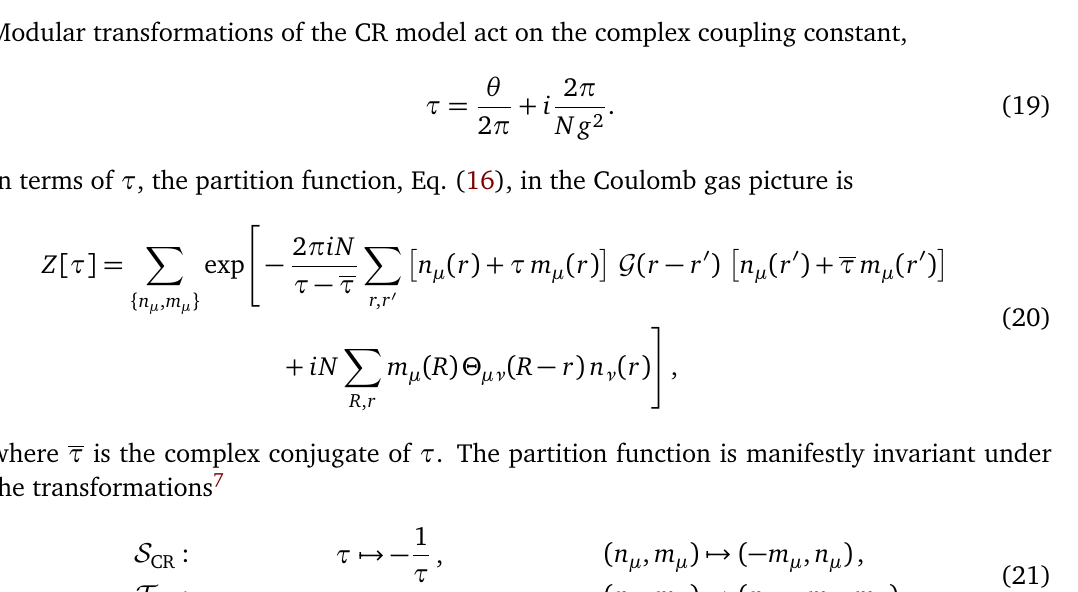
Figure 4: The phase diagram for the Cardy-Rabinovici model with N / C < 24 ] . Pink curves denote phase boundaries. The phases are labeled by ( n , m ) , indicat- ing that a dyon of electric charge Nn (without the additional polarization charge of the Witten effect) and magnetic charge m condenses. For larger N , Coulomb phases appear, separating the gapped condensed